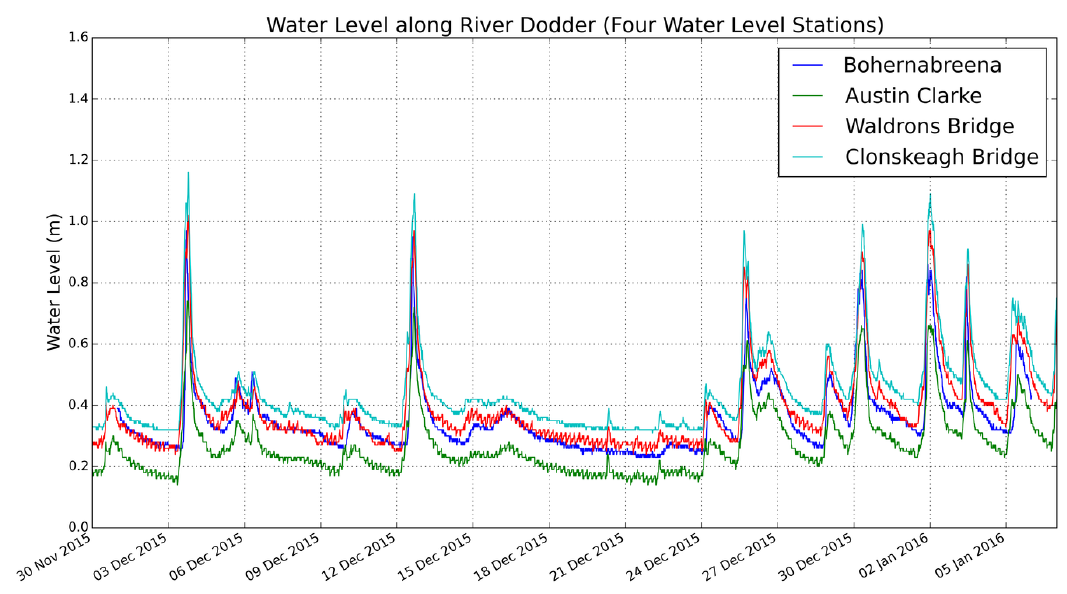
Figure 12. Raw sensor readings from Bohernabreena, Austin Clarke, Waldrons Bridge and Clonskeagh Bridge. Lag time can not be visually